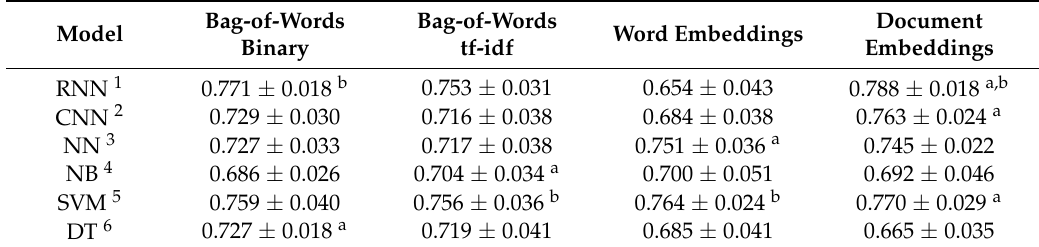
Table 4. The performance for optimal hyperparameter values for each of the representations combined with the models, based on a 5-fold stratified cross validation. The performance is measured in AUC, along with its standard deviation. The best performance over different models is marked with an a , the best performance over representations with a b . Bag-of-Words Bag-of-Words Document Model Word Embeddings Binary tf-idf